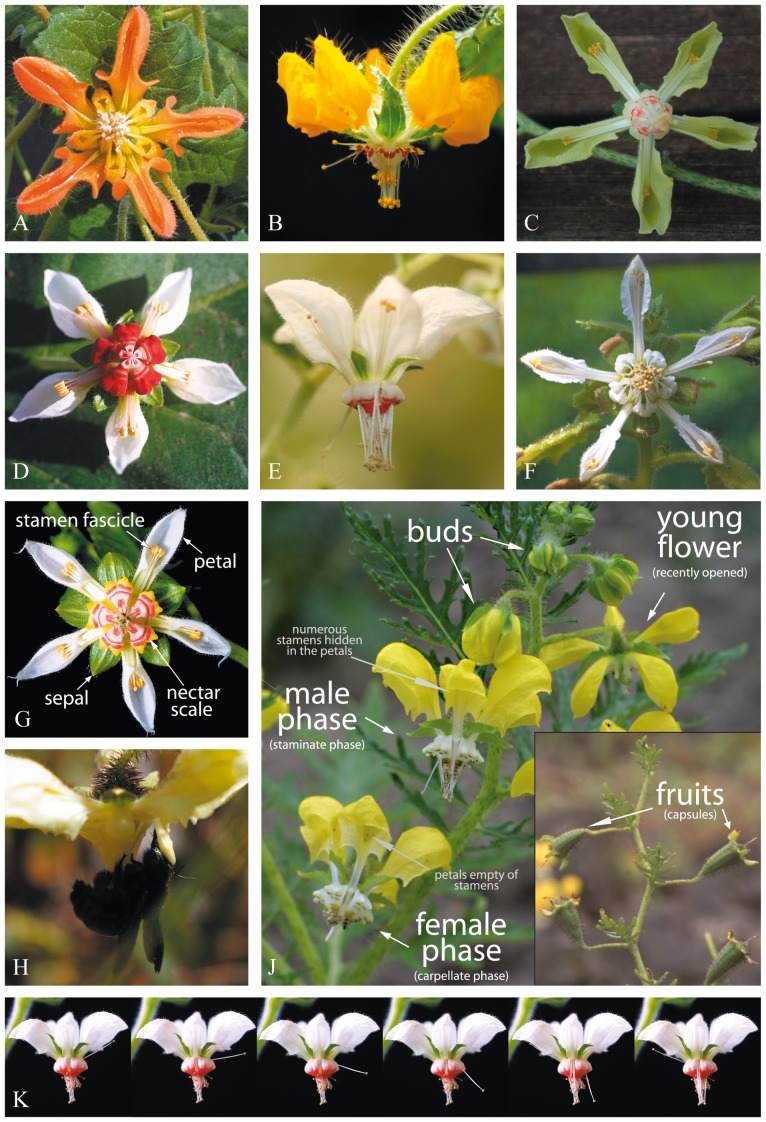
Flowers and floral morphology of species of Loasaceae subfam.Loasoidea used in this study. A. Caiophora cirsiifolia, B. Loasa insons, C. Nasa macrothyrsa, D. Nasa moroensis, E. Nasa vargasii, F. Presliophytum heucheraefolium, G. Flower of Nasa vargasii, important floral organs labelled, H. Neoxylocopa lachnea
[46], harvesting nectar on Nasa macrothyrsa, note the outwards bent nectar scale, J. Inflorescence of Nasa urens with flowers in different stages of the anthesis, right: fruiting inflorescence, K. Sequence of the stamen movement in Nasa vargasii. A mature stamen leaves the boat-shaped petal, passes the gap between two nectar scales and reaches the center of the flower to present its pollen.